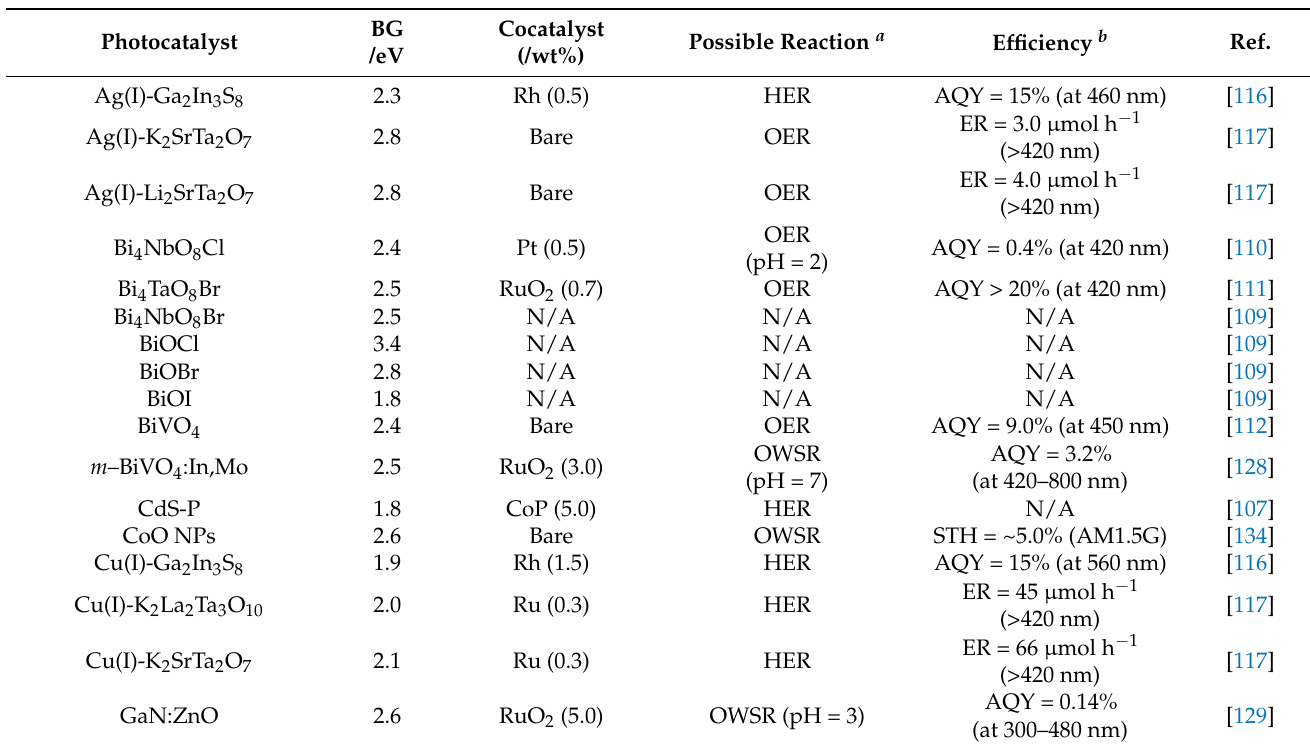
Figure 7. Band structures of ( A ) UV-light-driven and ( B ) Vis-light-driven water-splitting photocata- lysts. In this figure, only semiconductors for which the band structure at pH = 0 has been reported are described. For the BG values of these and other semiconductors, please also see Table 1 [51,87,90–99]. Table 1. BG, Effective cocatalysts, possible reaction, and efficiency of Vis-light-driven water-splitting photocatalysts introduced in Section